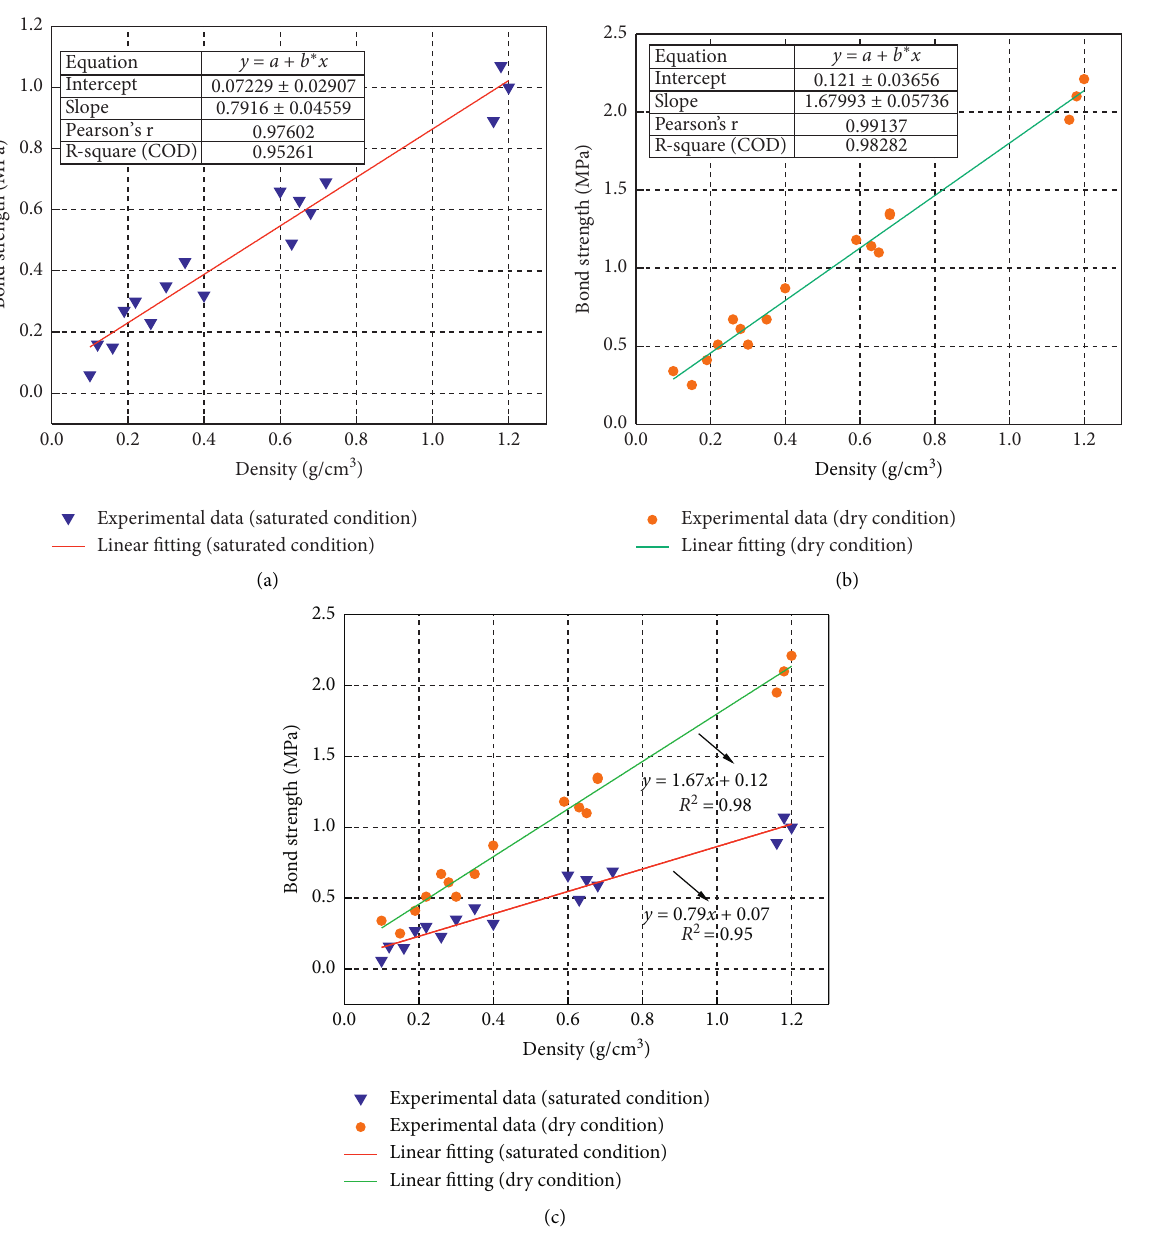
Figure 10: Relationship between polymer density and bond